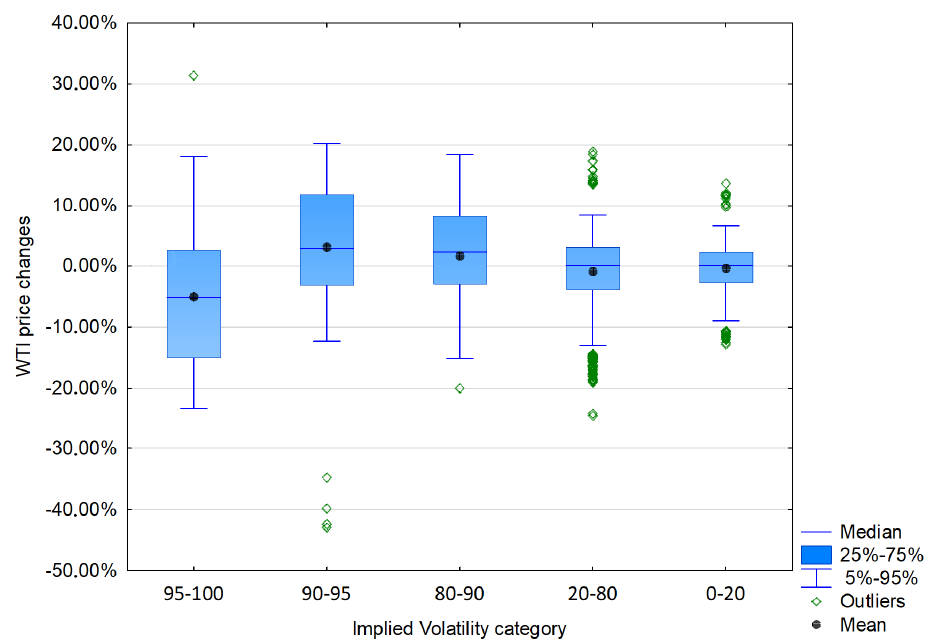
Figure 3. Box-and-whisker plot for the WTI crude oil price changes in five categories of implied